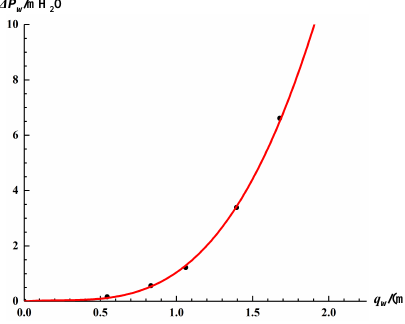
Figure 4. ∆ P w of the cooling system.